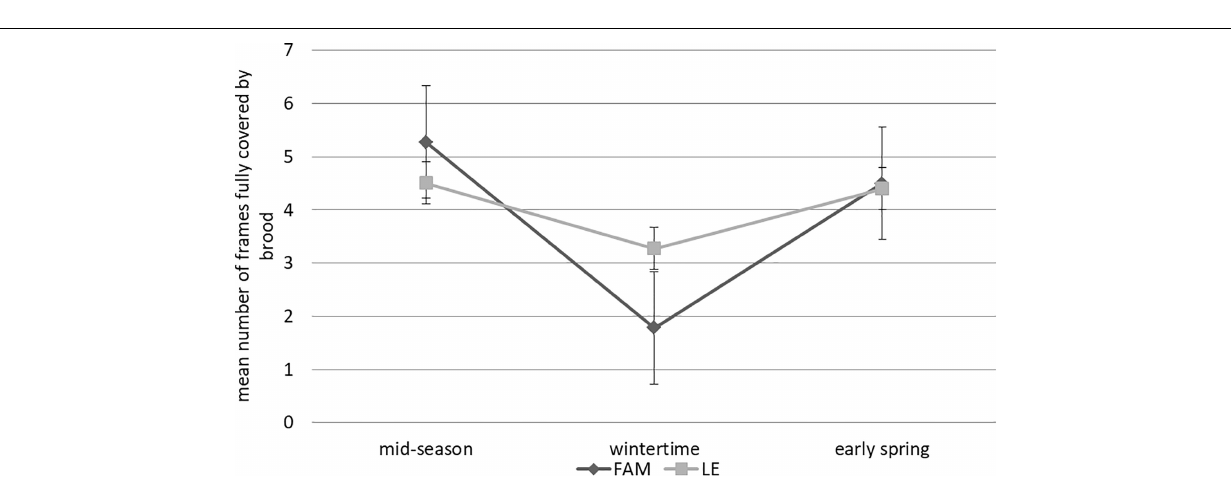
FIGURE 4 | Brood population of A. mellifera colonies from Leales (LE) and Famaillá (FAM) apiaries through the beekeeping season 2017–2018 (mid-season, wintertime and early spring). Mean values of number of frames fully covered by brood ( ± SE) are